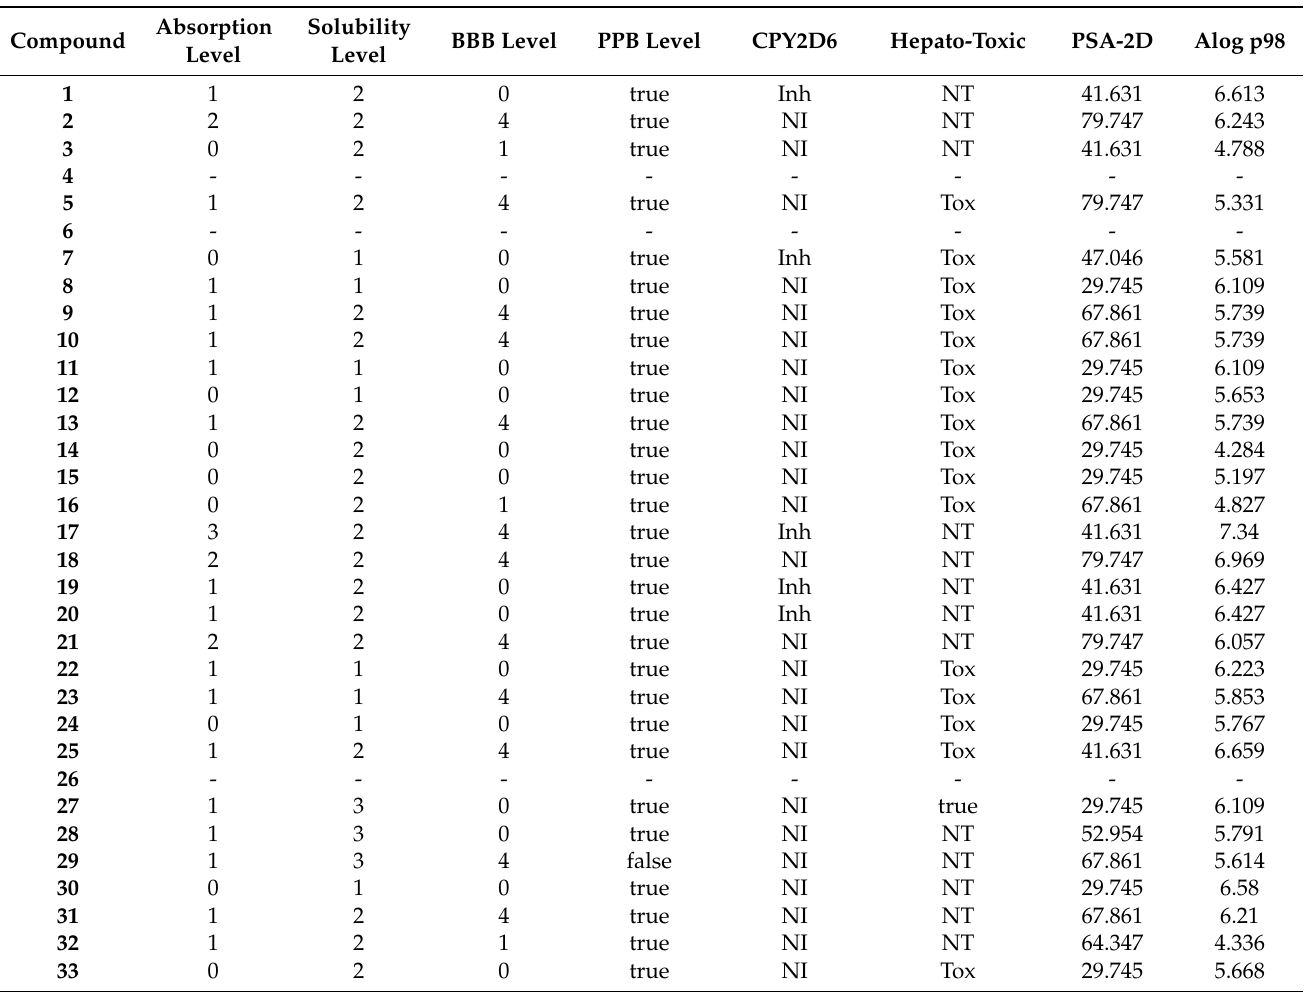
Table 2. Absorption, distribution, metabolism, excretion, and toxicity (ADMET) properties of the tested cannabinoids using drug discovery